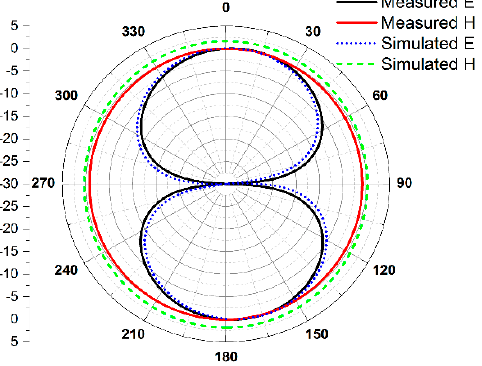
Figure 16. Measured and simulated radiation pattern for switches 2 and 3 ON, switches 4 and 5 OFF. Table 6. Summarized results of Case 4.